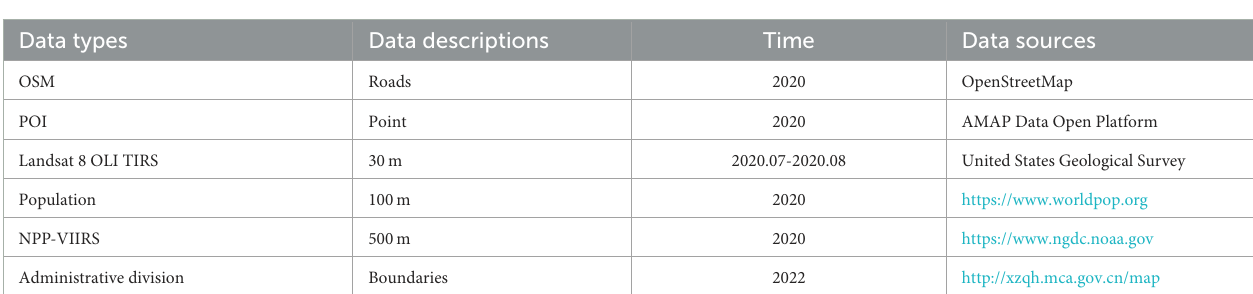
TABLE 1 Data sources and